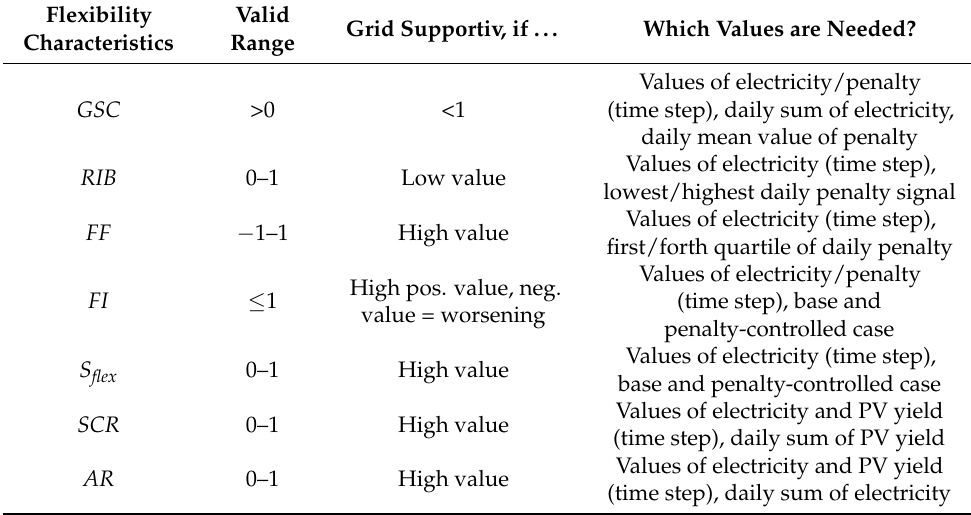
Table 3. Summary off all used flexibility